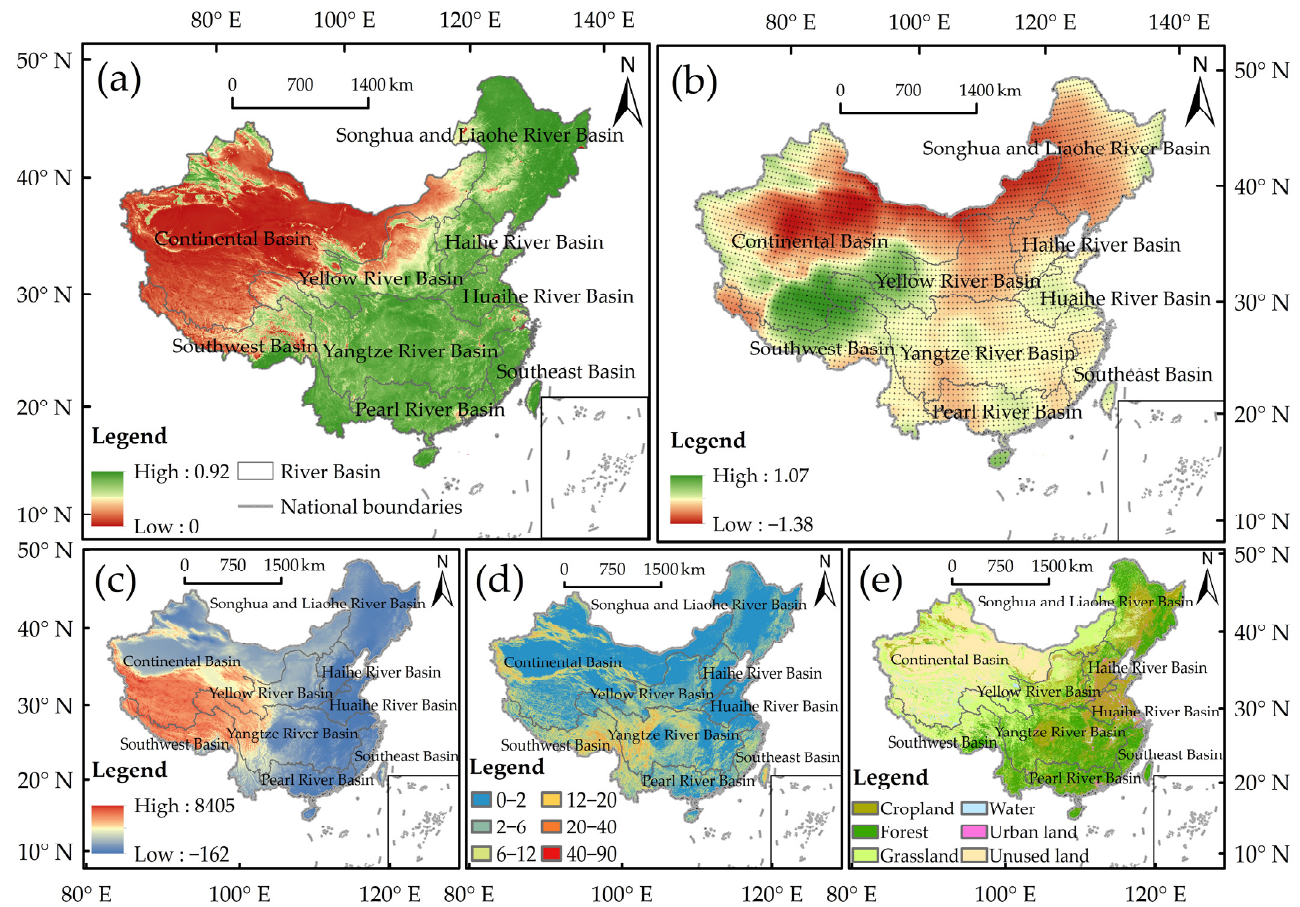
Figure 1. Main environmental characteristics of China: ( a ) Mean annual normalized difference vegetation index (NDVI) in nine river basins from 1998–2017; ( b ) mean annual standardized precipitation–evapotranspiration index (SPEI) and its grid point position from 1998–2017; ( c ) elevation; ( d ) slope; and ( e ) LUCC.